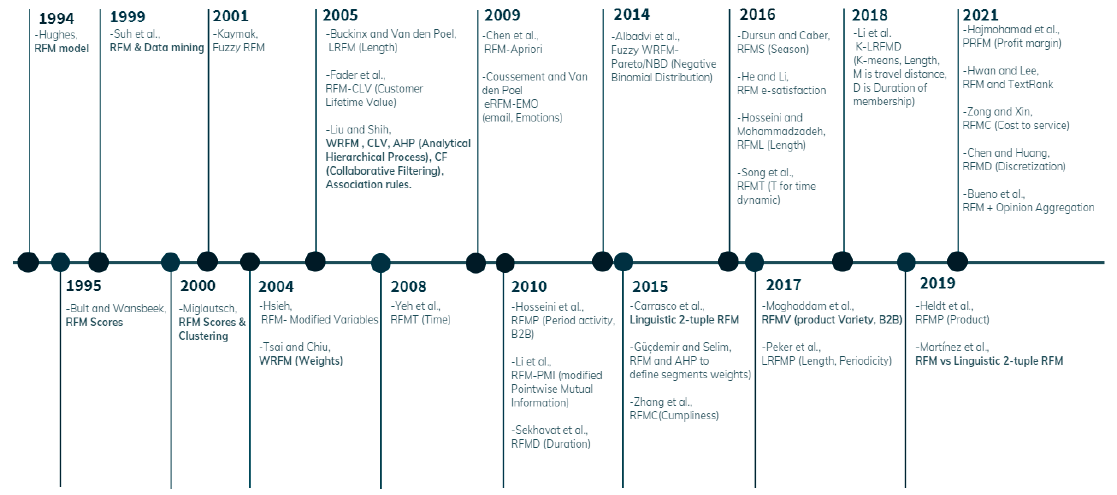
Figure 1. Timeline of RFM model’s main improvements of the RFM model.